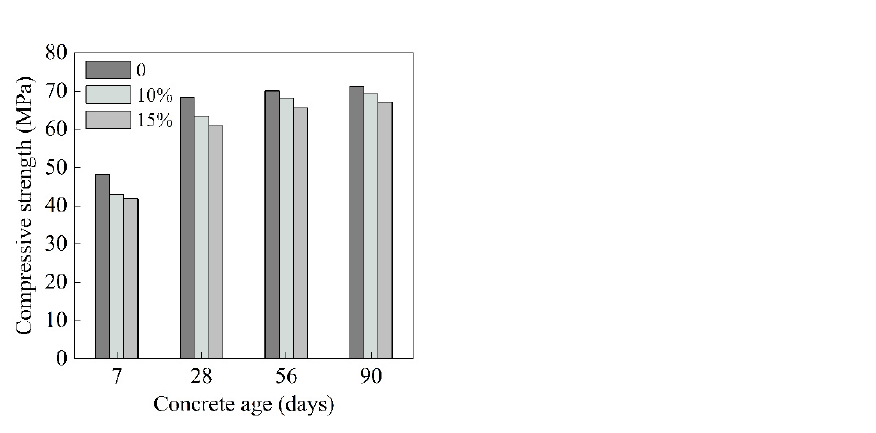
Figure 12. Variations of compressive strength with GBFS content of concrete [44].